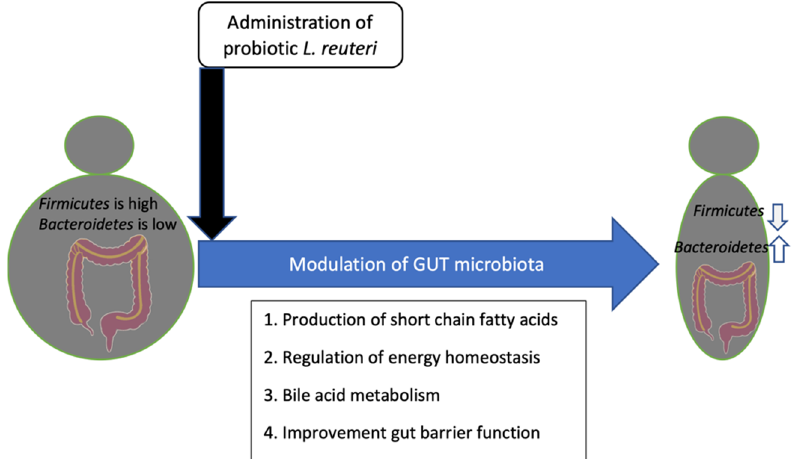
Figure 2. Effect of probiotic L. reuteri strains on obese people.